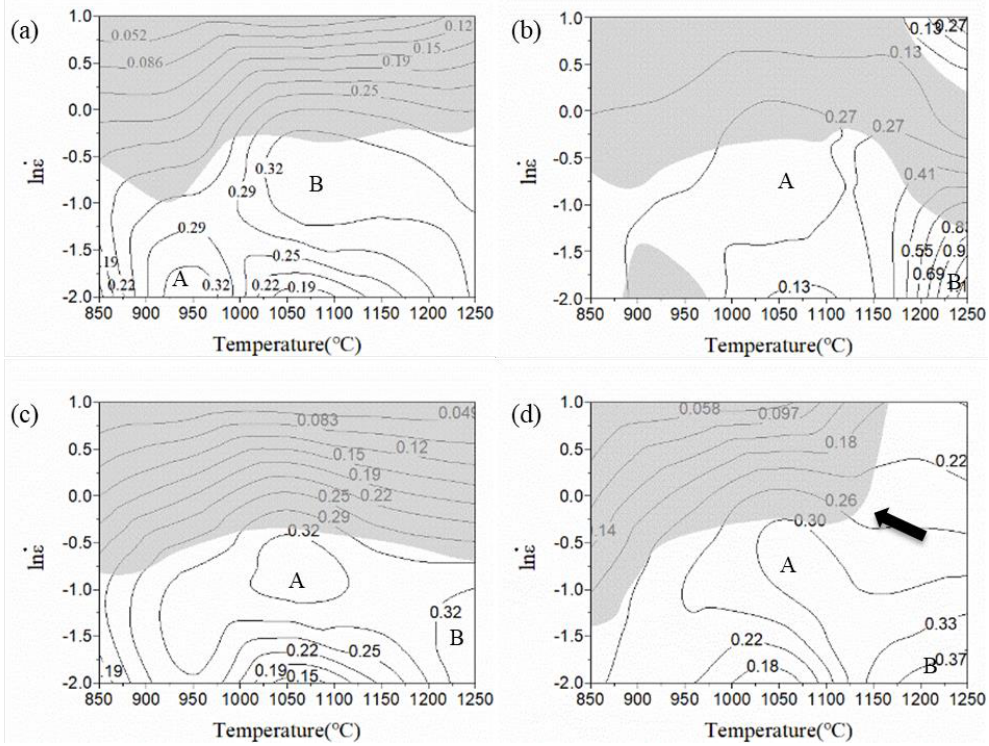
Figure 7. Processing maps of the experimental Nb-V-Ti free-cutting steel at the true strain of: ( a ) 0.3, ( b ) 0.4, ( c ) 0.5, ( d ) 0.6.